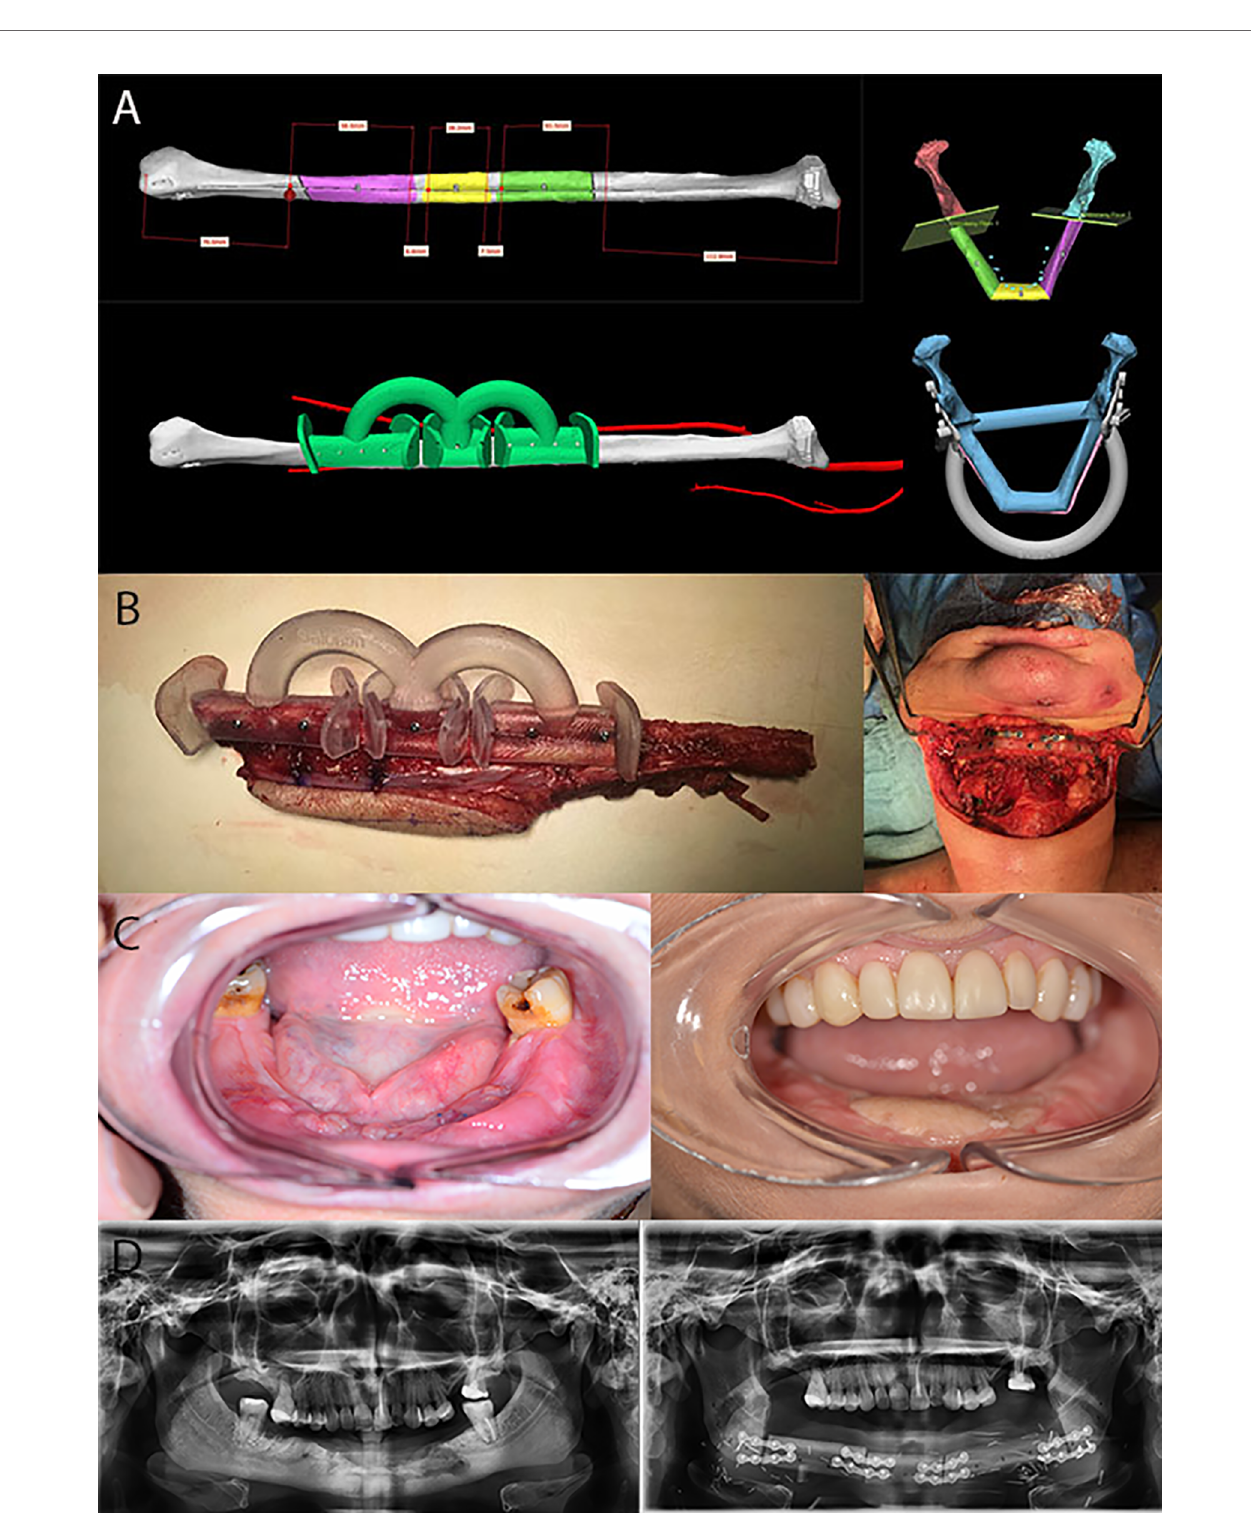
FIGURE 2 | Computer-assisted surgical planning and execution for a squamous cell carcinoma reconstruction. (A) Preoperative virtual analysis and planning. (B) Fibular graft fabrication assisted by guided templates. (C) Preoperative and postoperative intraoral photos of squamous cell carcinoma resection with mandibular reconstruction. (D) Preoperative and postoperative panoramic radiographs.